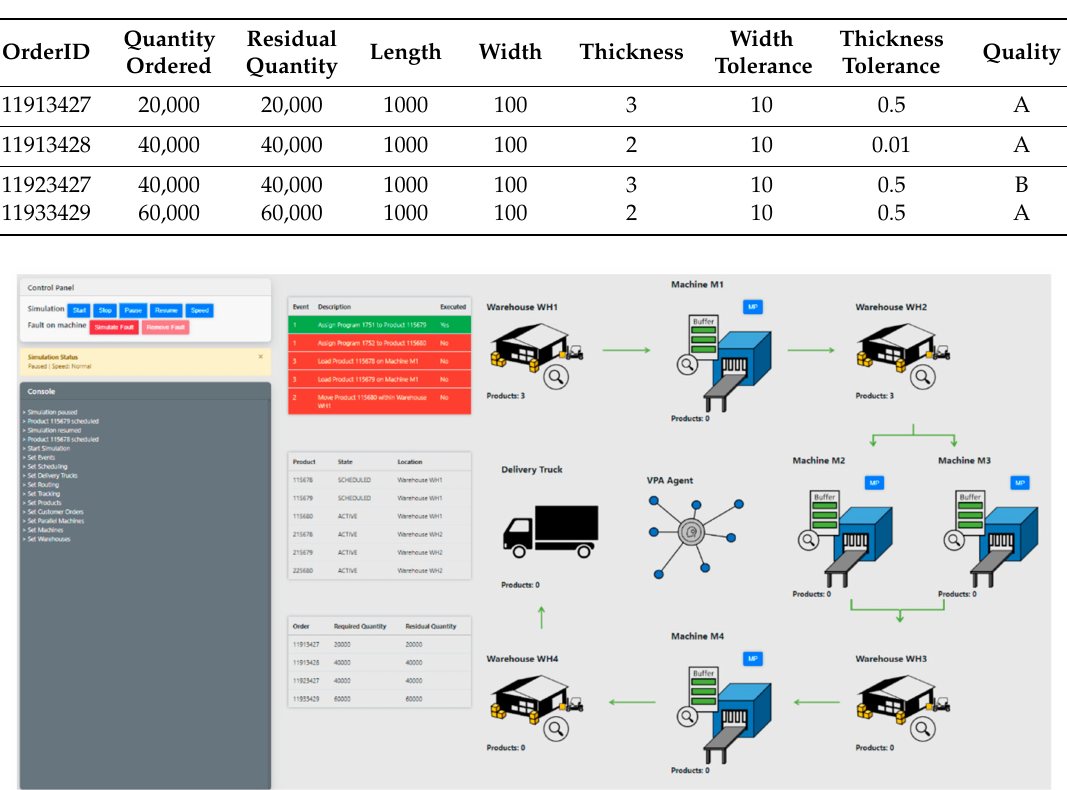
Table 9. Production order information.